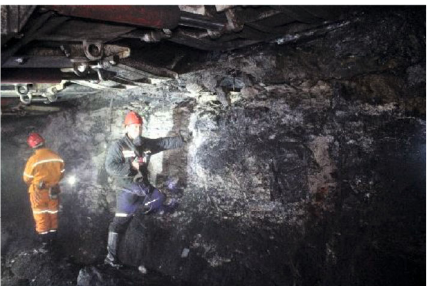
Figure 16: The working face passes through the abandoned roadway.